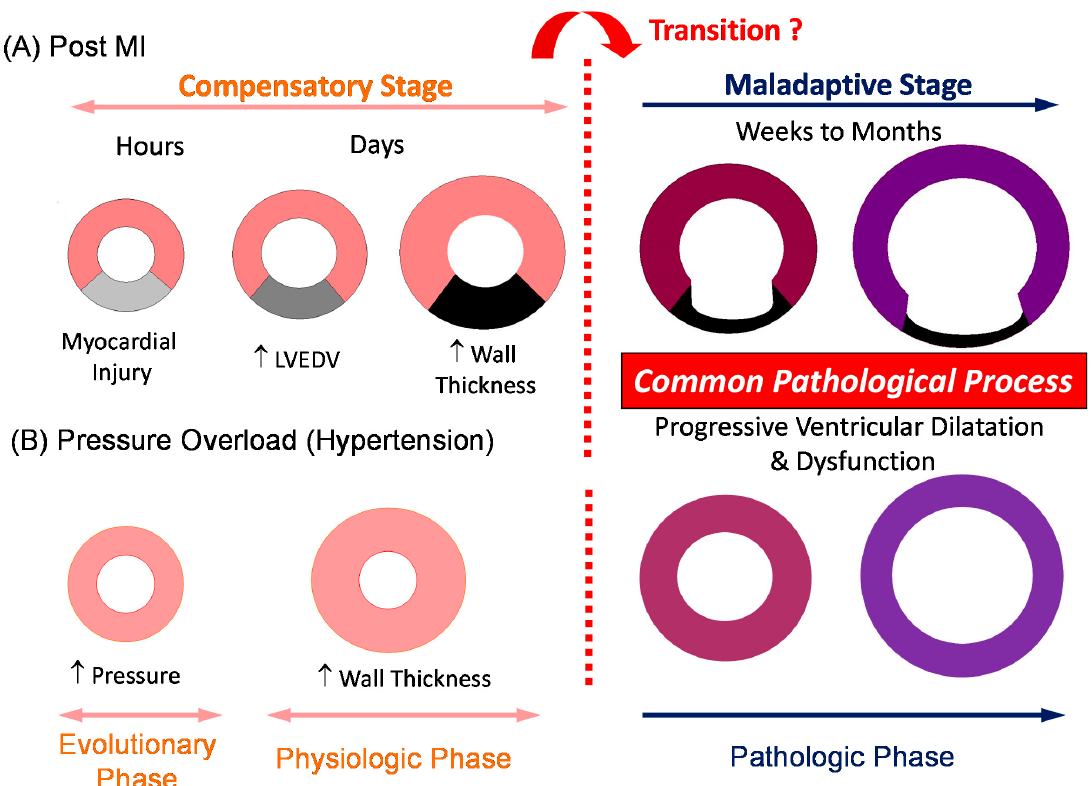
Figure 1. A sequence of ventricular remodeling in post-myocardial infarction (post-MI) ( A ) and persistent pressure overload ( B ) models from compensatory (evolutionary and physiologic) to maladaptive (pathologic) stages. During the compensatory stage, the ventricular myocardium undergoes initial morphological and biochemical changes (compensatory responses) to maintain necessary cardiac output and to regulate myocardial oxygen demand under control. A pathologic transition into an irreversible and progressive stage may occur when the regulatory capacity of myocardial oxygen demand is disrupted. LVEDV = left ventricular end ‐ diastolic volume; MI = myocardial infarction.